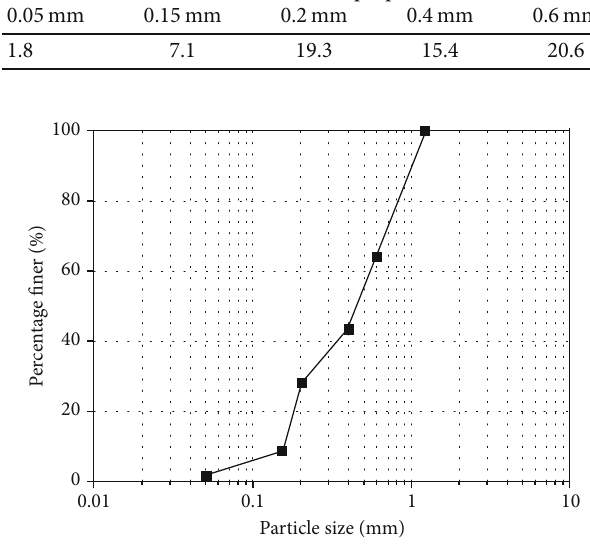
Figure 3: Grain size distribution curves of the test